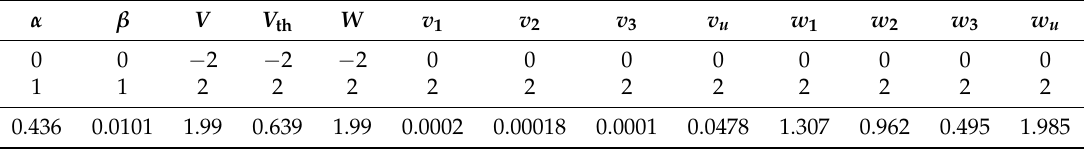
Table 4. BELBIC controller parameters obtained using particle swarm optimization